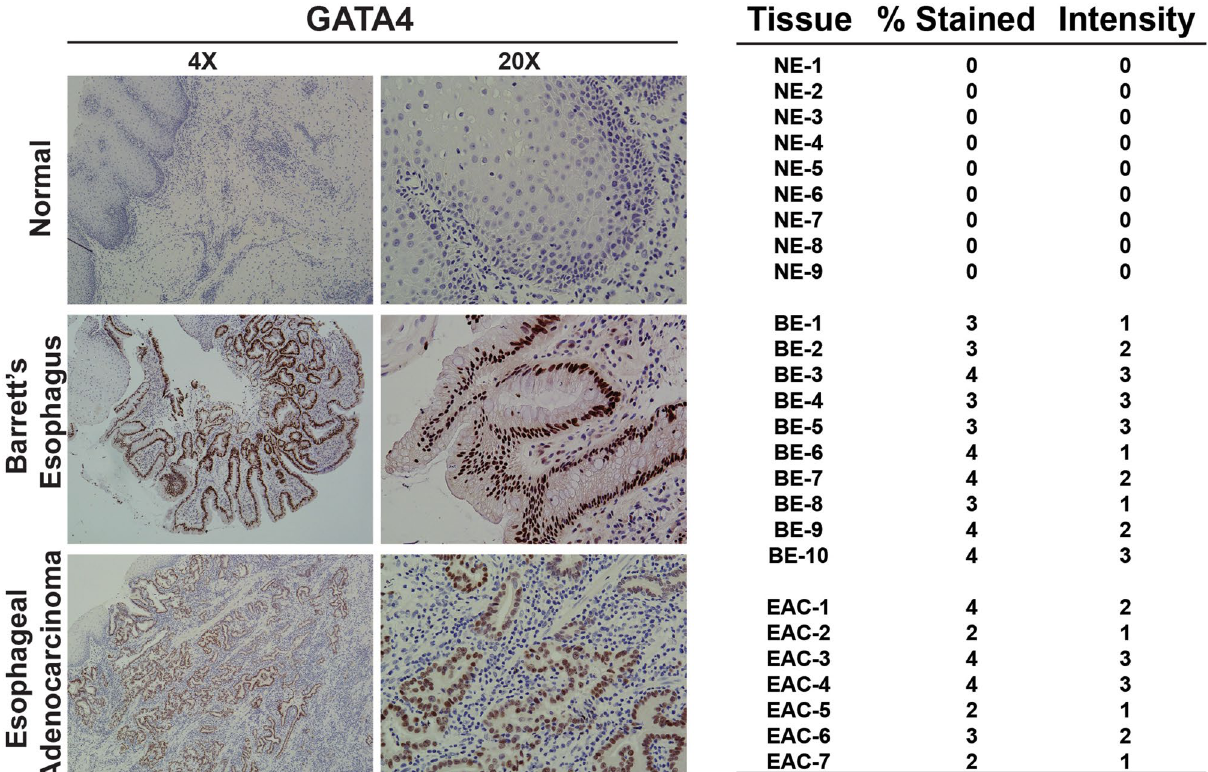
Figure 6. Human Barrett’s esophagus lesions and esophageal adenocarcinoma tumors aberrantly express GATA4. Tissue sections (5 µm) of de-identified human esophageal biopsy tissue without disease (n = 9), with Barrett’s esophagus (n = 10), or with esophageal adenocarcinoma (n = 7) were obtained from the MCW Tissue Bank and Department of Pathology. Immunohistochemistry was used to detect GATA4 protein (brown nuclear staining). No GATA4 protein was detected in normal tissue, whereas all BE and EAC tissues analyzed expressed GATA4 protein in diseased epithelial cells. Sections were counterstained with hematoxylin. A board-certified GI pathologist scored GATA4 staining in BE and EAC tissue samples. The scoring rubric used was two-part. The percentage of GATA4 positive cells within the BE or EAC lesion were scored as 0 = 0% positive cells; 1 = 1%-25% positive cells; 2 = 26%-50% positive cells; 3 = 51%-75% positive cells; 4 = 76%-100% positive cells. The GATA4 staining intensity was scored as 0 = no staining; 1 = weak staining; 2 = moderate staining; 3 = strong staining. Scale bar, 100